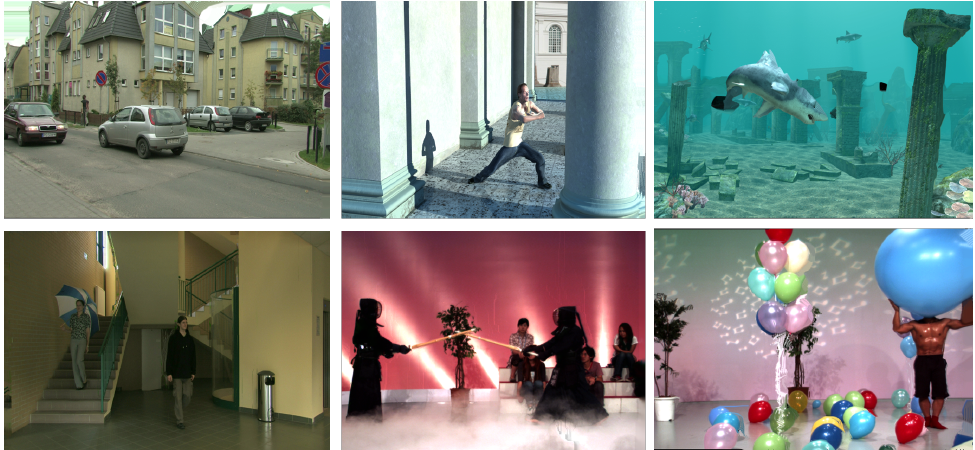
Figure 4. Examples of the DIBR sythesized views of IETR